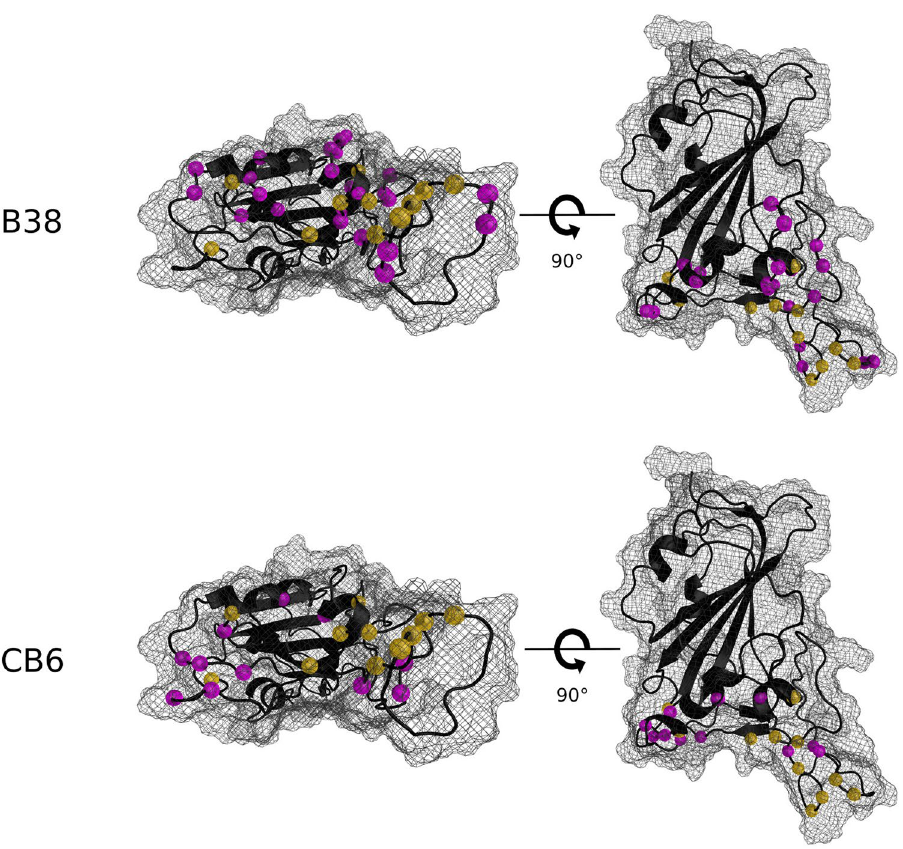
Figure 3. The S-RBD amino acid sites predicted to contain antibody escape mutations (magenta) by MD + FoldX or PyRosetta (i.e., all sites listed in Table 1). The S-RBD sites that are predicted to harbor antibody escape mutations for both B38 and CB6 are shown in gold. For both B38 (top) and CB6 (bottom) two views are shown to provide context. The S-RBD is indicated in black, with the surface shown as a